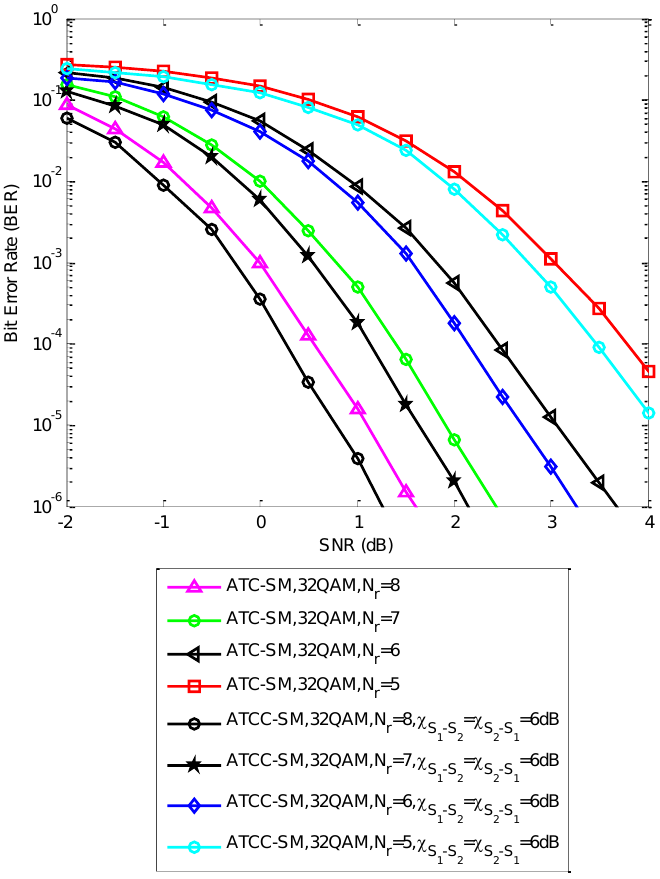
Figure 10. BER performance of the two-source ATCC-SM scheme under a non-ideal inter-user channel scenario and ATC-SM based on the CMI over the slow Rayleigh fading channel, K = 1024, 32QAM, N t = 8 and different numbers of receive antennas.